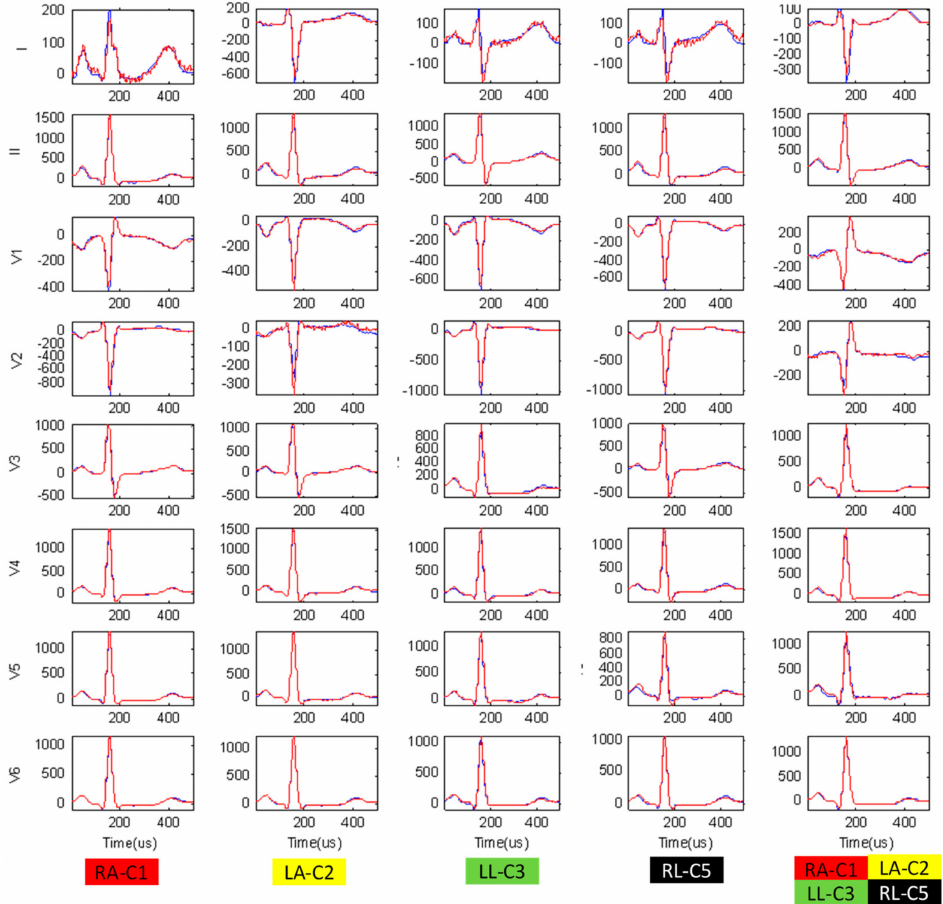
Figure 3. The average beat of 8 independent leads (I, II, V1-V6) taken from the same subject in two scenarios: (1) Red trace: Recorded ECG with swapped unicolor electrodes; (2) Blue trace: Simulated ECG with swapped unicolor electrodes, applying Forward ‘MSMinv’ transformation on the ECG recorded with the correct lead